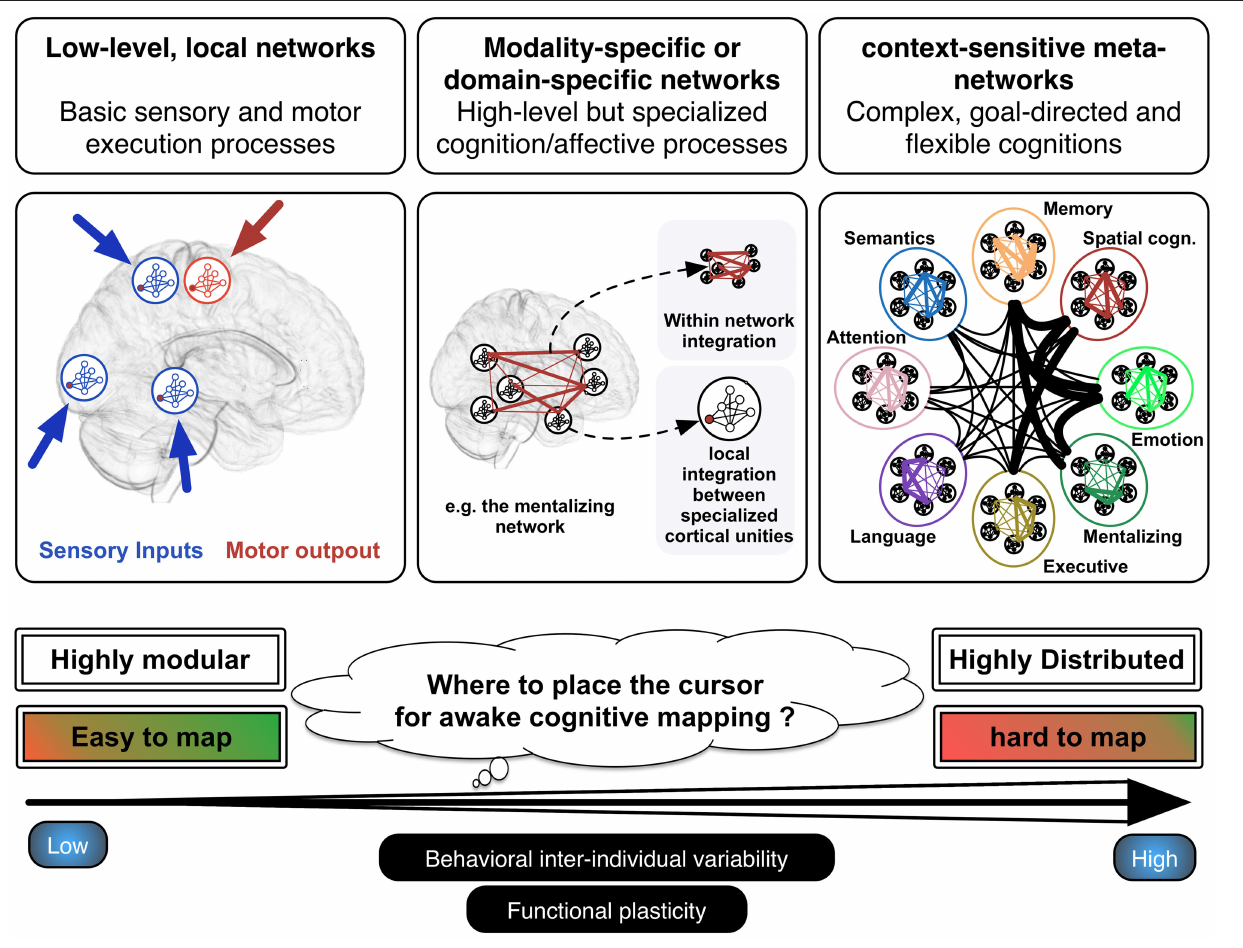
FIGURE 1 | Hierarchical functioning of the anatomo-functional architecture. Basic sensorimotor processes are performed by low-level, local and highly modular networks, whereas modality-specific or domain-specific functions are rather underlain by distributed networks. The latter are composed of different cortical epicenters, the functional integration of which is permitted by anatomical connectivity. At a higher level, complex or flexible cognitions or behavior result from the instantiation of meta-networks, which consist in specific and unique patterns of cross-network integration transiently generated to reach the task demands. Adapted from Herbet and Duffau ( 16) with